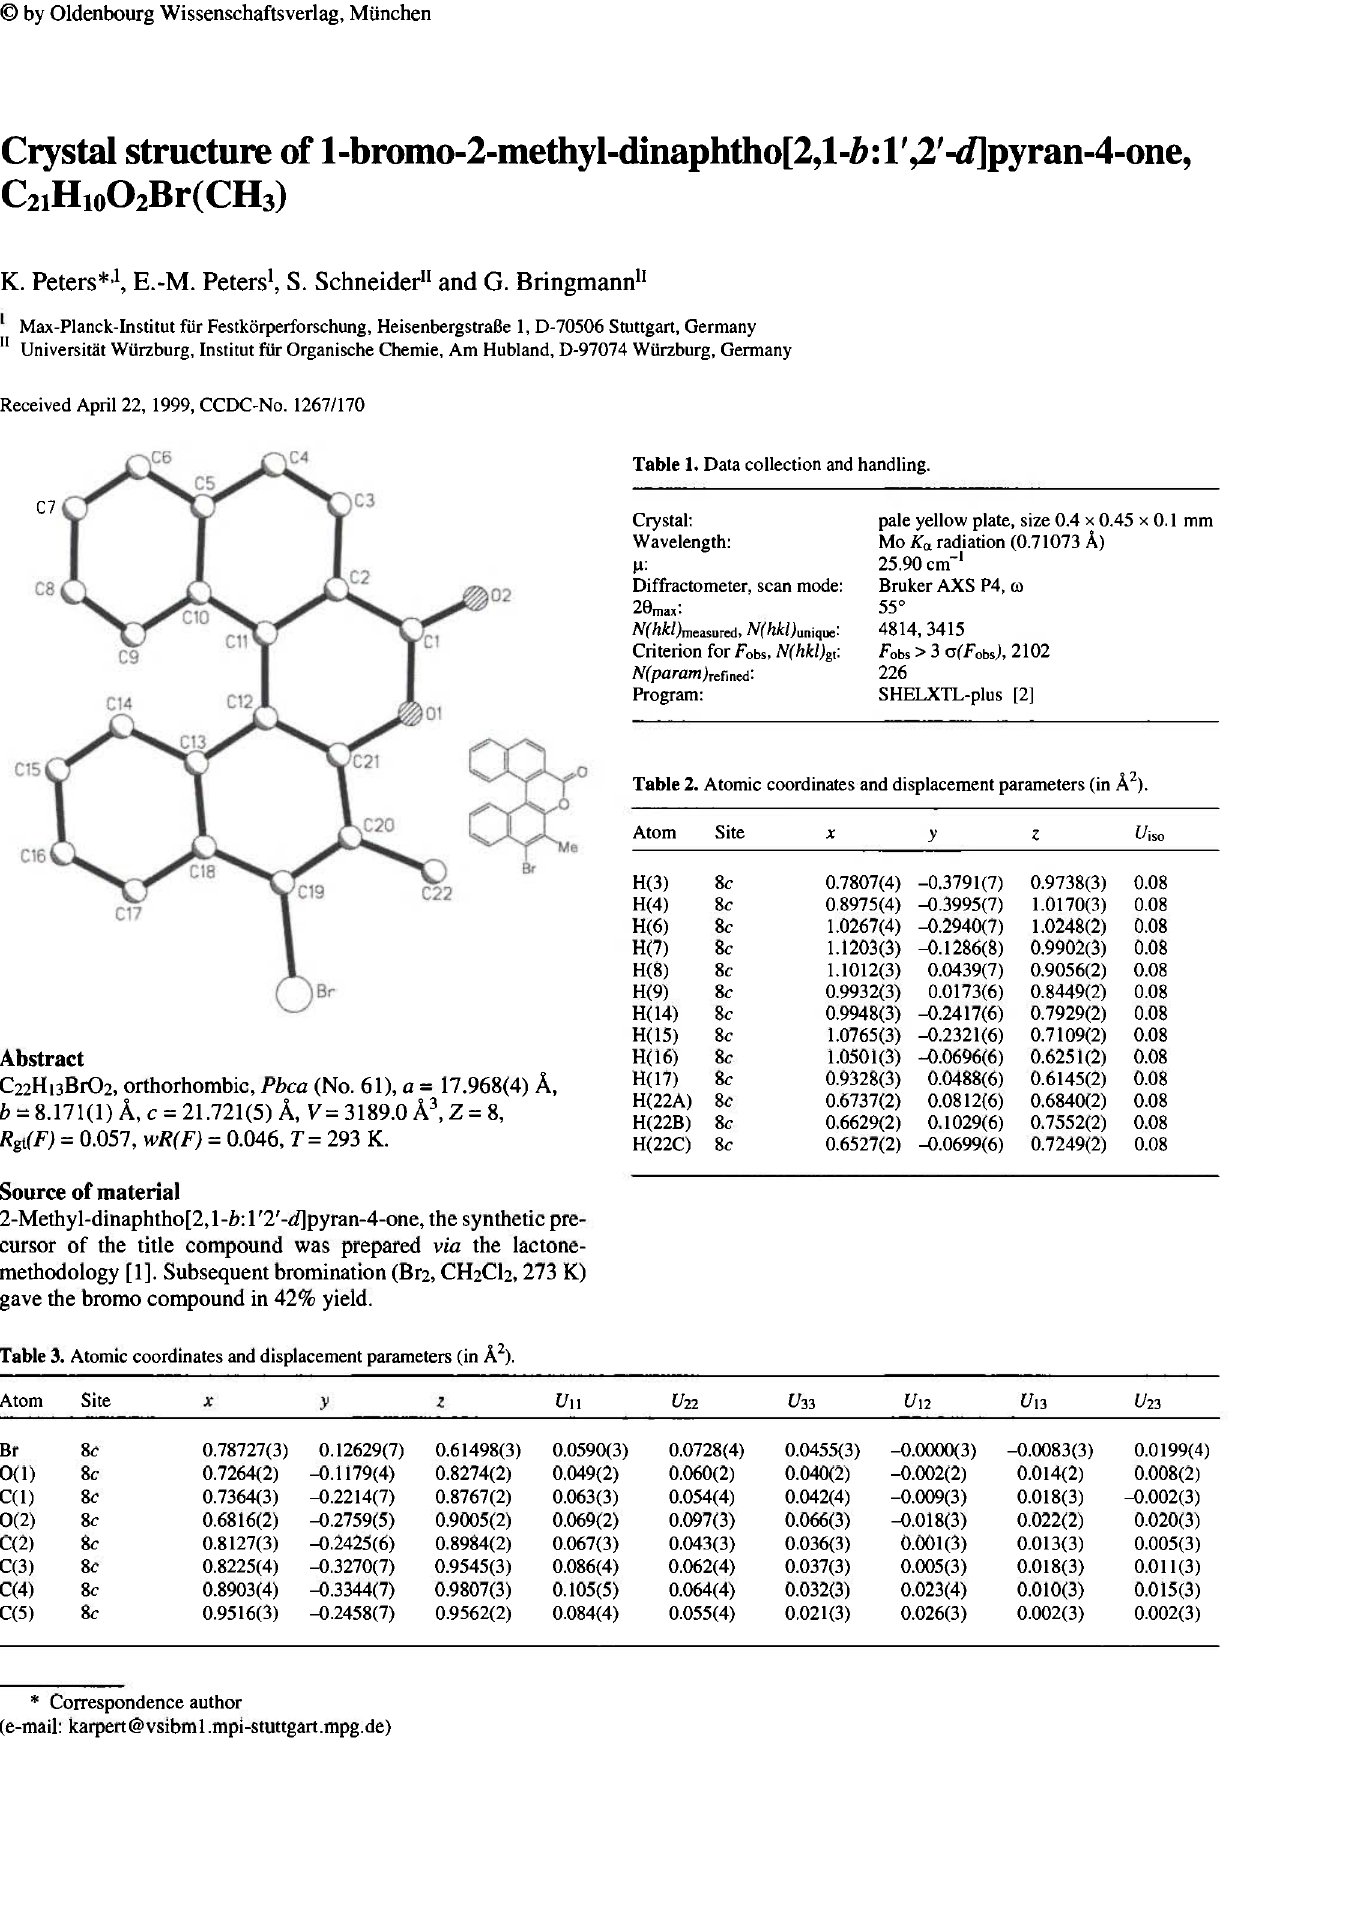
Table 1. Data collection and handling.